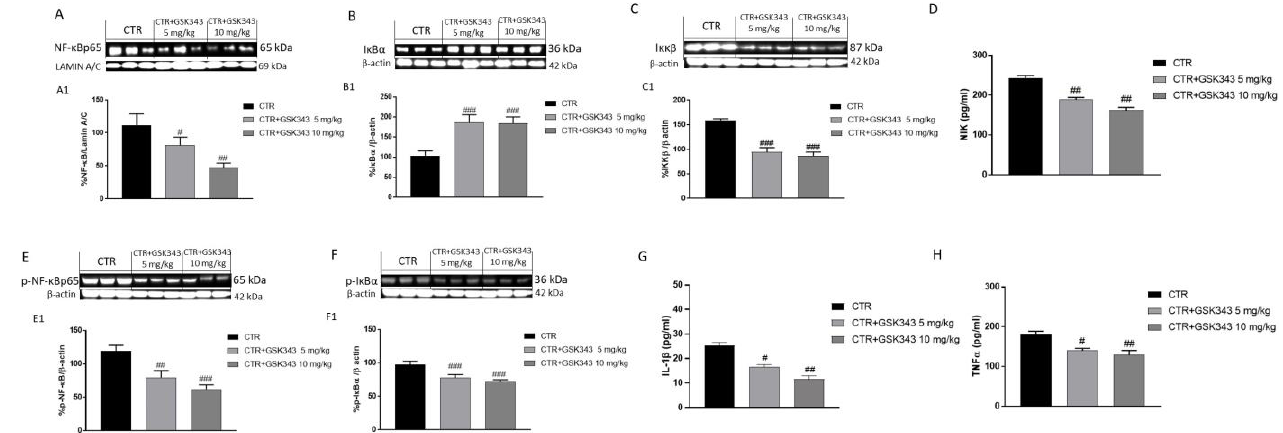
Figure 6. Effect of GSK343 on canonical and non-canonical NF- κ B/I κ B α pathways in the U87-xenograft model. The blots demonstrated that the treatments with GSK343 at doses of 5 mg/kg and 10 mg/kg significantly reduced NF- κ B translocation into the nucleus ( A ), IKK β expression ( C ) and restored I κ B α cytosolic expression ( B ); NIK level was reduced following GSK343 treatment ( D ). Our results were confirmed for phosphorylated proteins p-NF- κ B and p-I κ B- α ( E , F ). Moreover, the ELISA assays demonstrated that GSK343 5 mg/kg and 10 mg/kg significantly reduced IL-1 β ( G ) and TNF- α levels ( H ) compared to the control group. Data are representative of at least three independent experiments. ( A ) # p < 0.05 vs. Ctr; ## p < 0.01 vs. Ctr; ( B ) ### p < 0.001 vs. Ctr; ( C ) ### p < 0.001 vs. Ctr; ( D ) ## p < 0.01 vs. Ctr; (E) ## p < 0.01 vs. Ctr, ### p < 0.001 vs. Ctr; ( F ) ### p < 0.001 vs. Ctr; ( G )